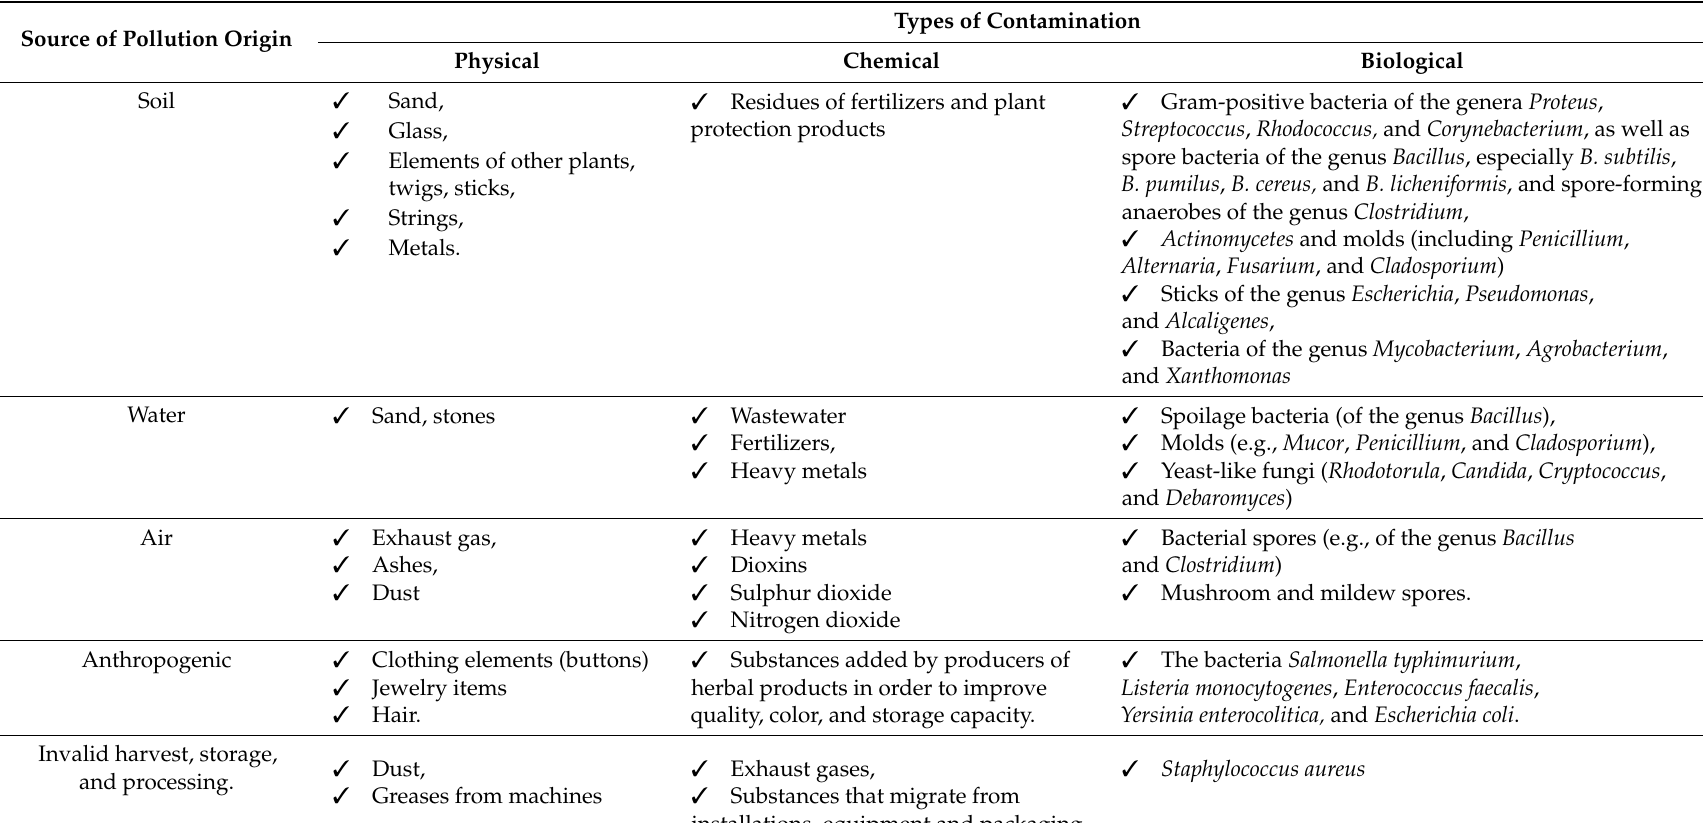
Table 1. Types of herbal